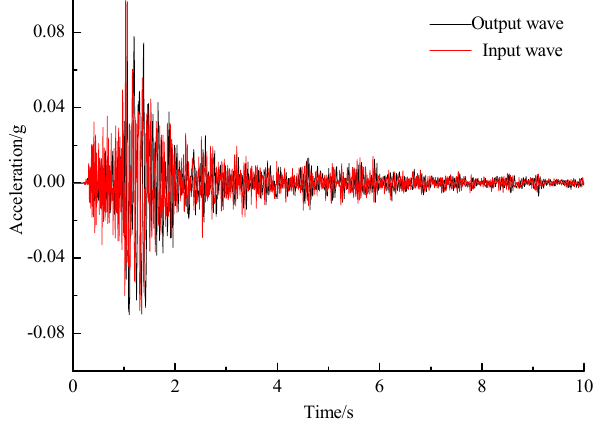
Figure 14. Input and output acceleration time history curves.